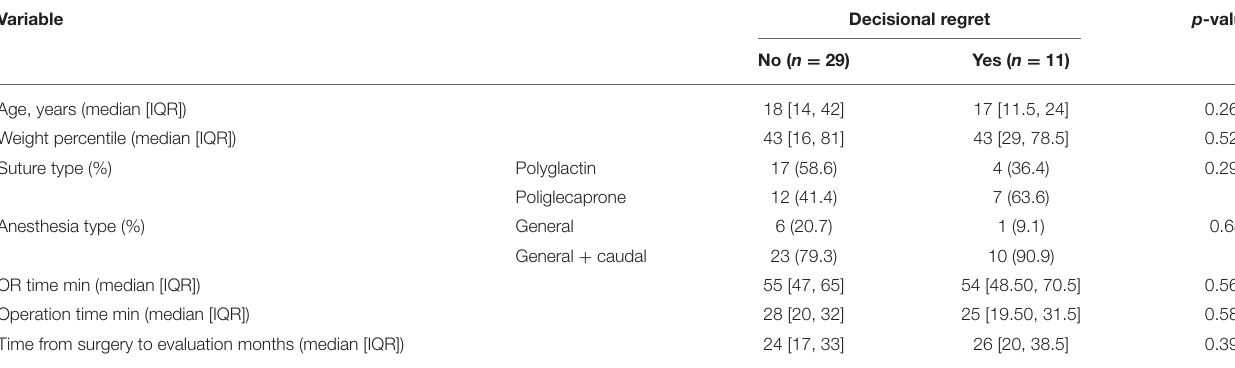
TABLE 2 | Clinical characteristics of the study cohort stratified by parental decisional regret ( n = 40).